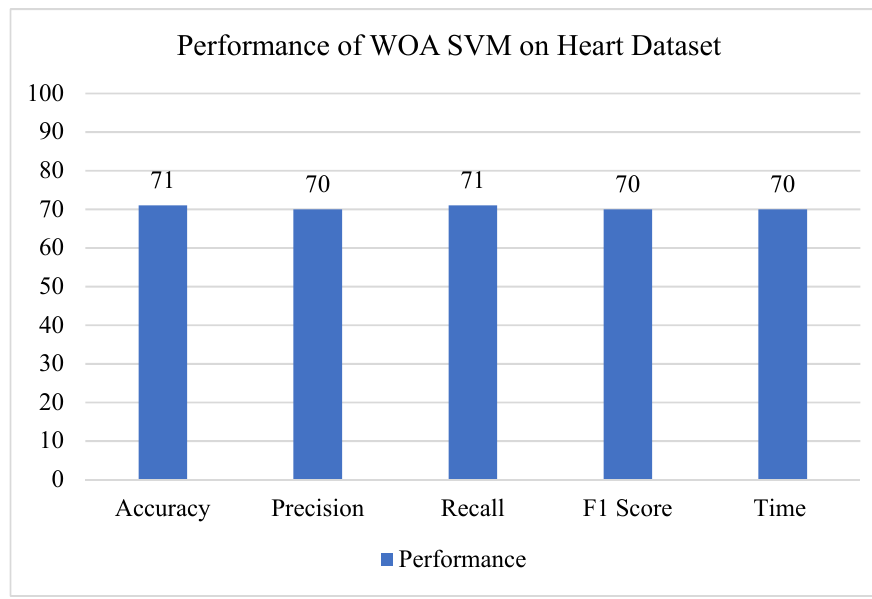
Figure 16. Performance of WOA ‐ SVM in Heart Disease . The selected best WOA ‐ SVM parameters are shown in Table 5. Table 5. Selected best WOA ‐ SVM parameters.